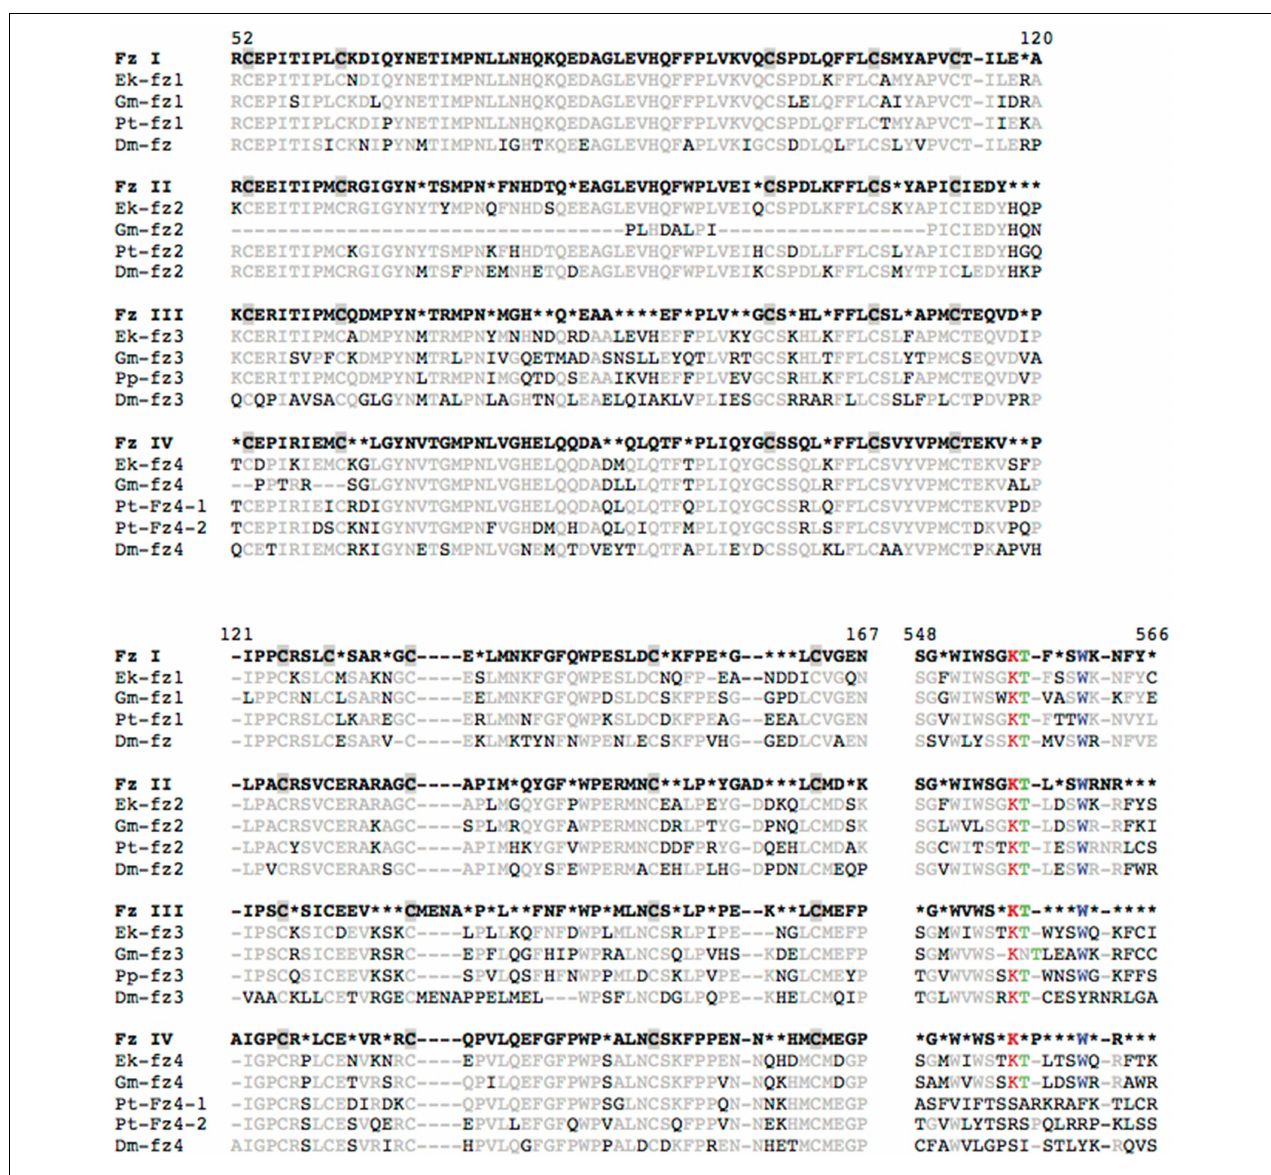
FIGURE 3 | Sequence alignments of the cystein rich domain (CRD) and KTxxxW motif of arthropod Frizzled proteins. Sixty percent consensus sequences, based on the alignment of the Frizzleds from all 10 species depicted in Figure 2 , are shown in bold type separately for orthology groups FzI-IV. Individual sequences are shown for Euperipatoides kanangrensis (Ek), Glomeris marginata (Gk), Parasteatoda tepidariorum (Pt), and Drosophila melanogaster (Dm).